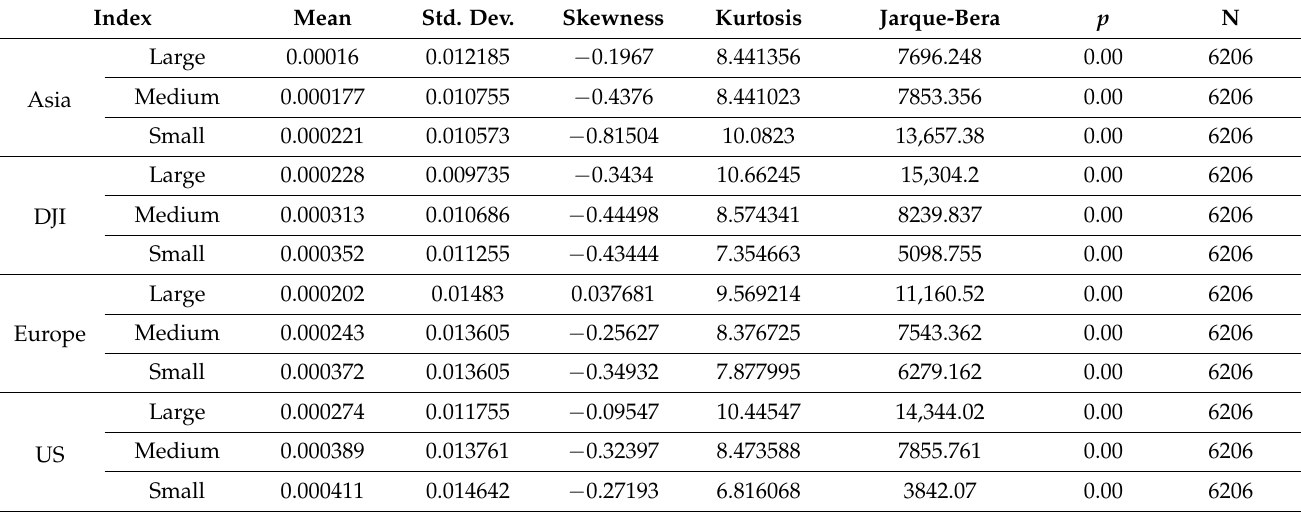
Table 1. Descriptive statistics for return of Islamic index per size